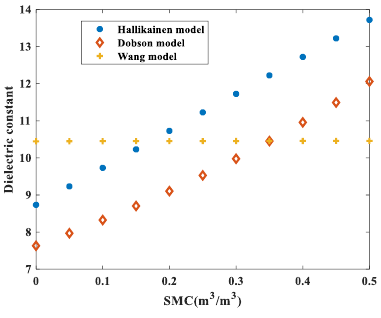
Figure 19. Effects of sand on soil dielectric